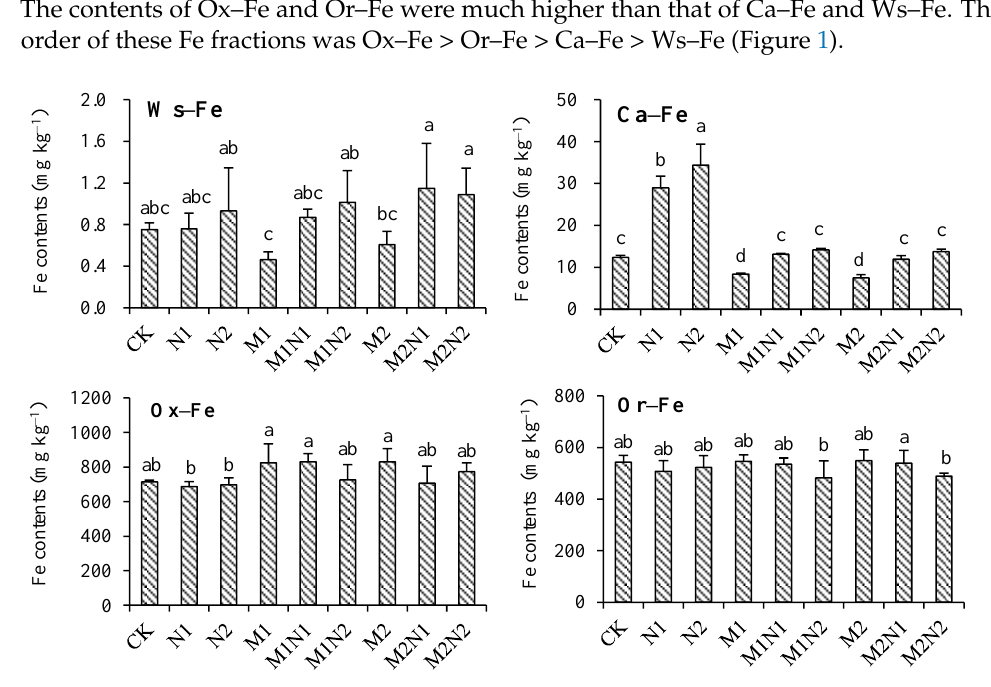
Figure 1. Contents of continuous–extraction Fe in bulk soil after 38–year fertilization with nine treatments. CK: no fertilizer, N1: low nitrogen, N2: high nitrogen, M1: low manure, M1N1: low manure and low nitrogen, M1N2: low manure and high nitrogen, M2: high manure, M2N1: high manure and low nitrogen, M2N2: high manure and high nitrogen. Ws–Fe: water–soluble Fe, Ca– Fe: carbonate–bound Fe, Ox–Fe: iron–manganese–oxide–bound Fe, Or–Fe: organic–matter–bound Fe. Different lower–case letters denote significant differences between treatments by least–significant difference at the 5% level.